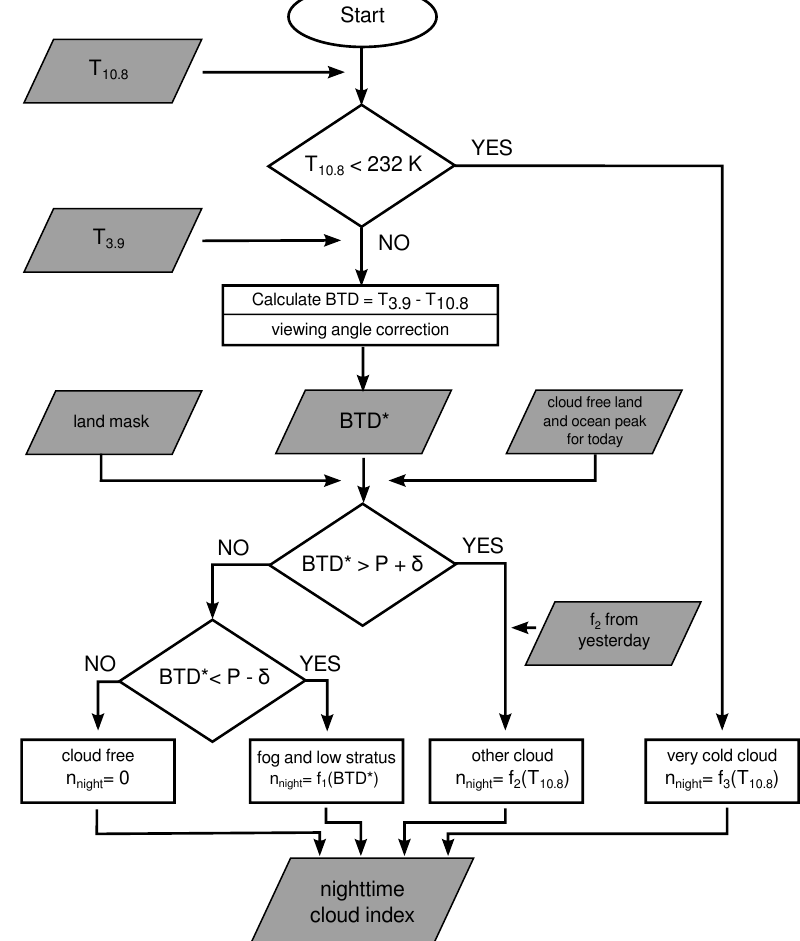
Figure 7. Overview of the new nighttime cloud index scheme. The cloud classification is based on the brightness temperature difference